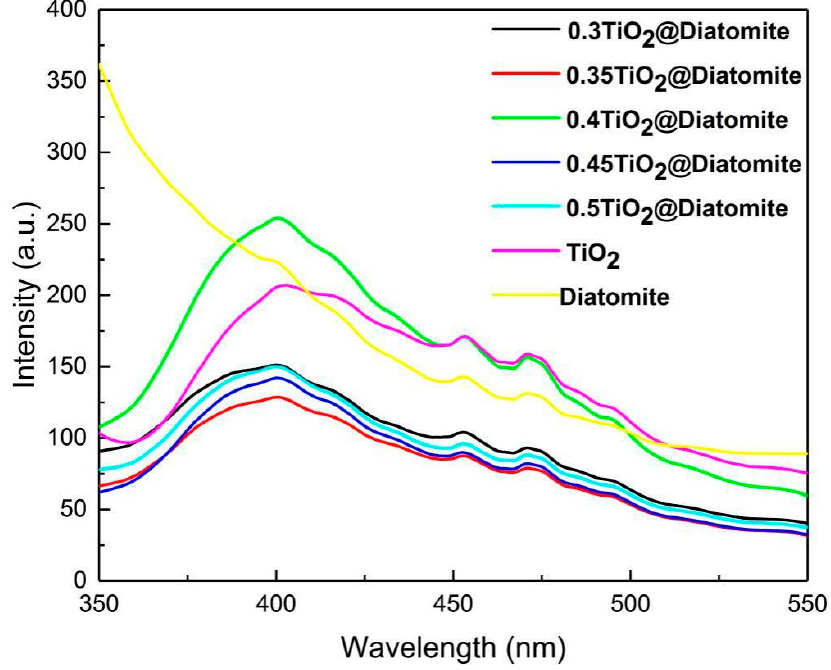
Figure 6. Photoluminescence (PL) spectra of TiO 2 , diatomite, and XTiO 2 @diatomite.